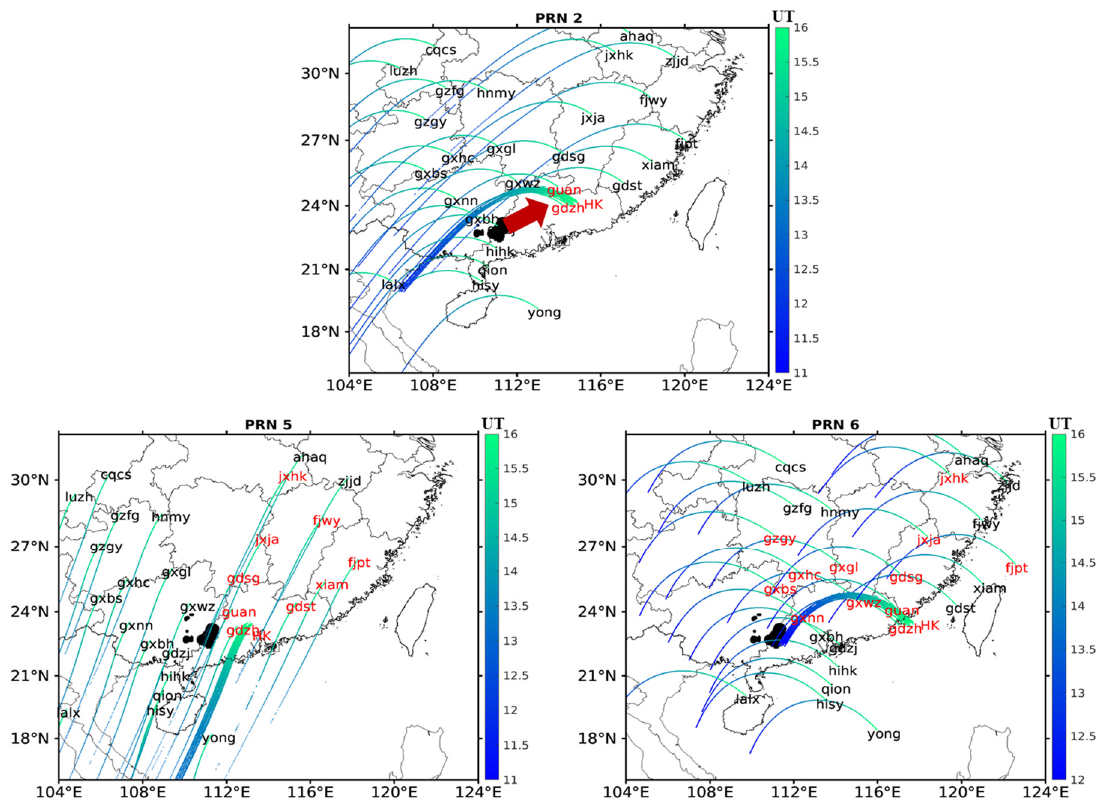
Figure 4. Trajectories of the satellite IPP of PRN 2, 5, and 6 from 14 h to 17 h on 3 April 2019. The color axis represents universal time. The black patches are thunderstorm areas. Hong Kong’s dense stations are represented by ‘HK’. The names of disturbed stations before and around 16 h are marked in red.